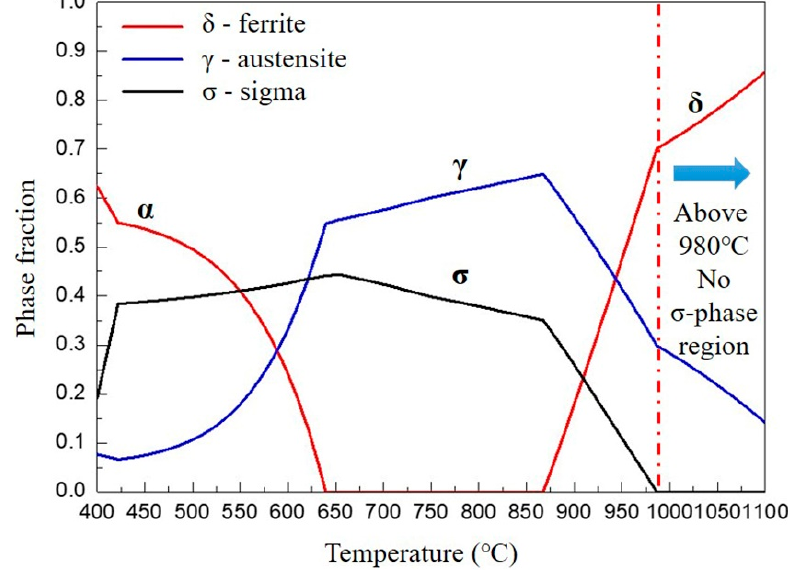
Figure 2. Various phase fractions versus temperature in SAF 2507 super duplex stainless steel predicted by Thermo-Calc.